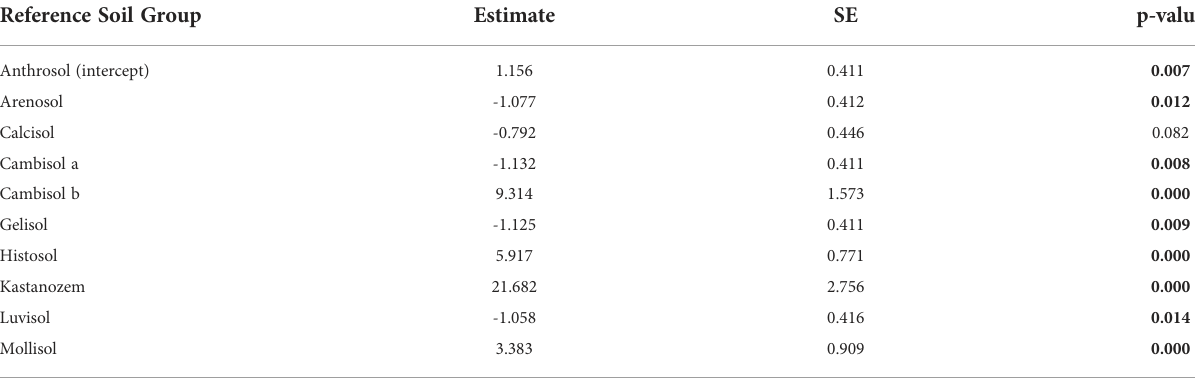
TABLE 2 Summary table of GLM predicting total amino sugars (mg/g) by reference soil